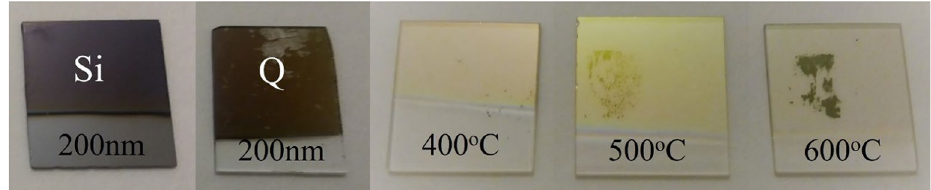
Figure 1. NiO thin films deposited on Si and